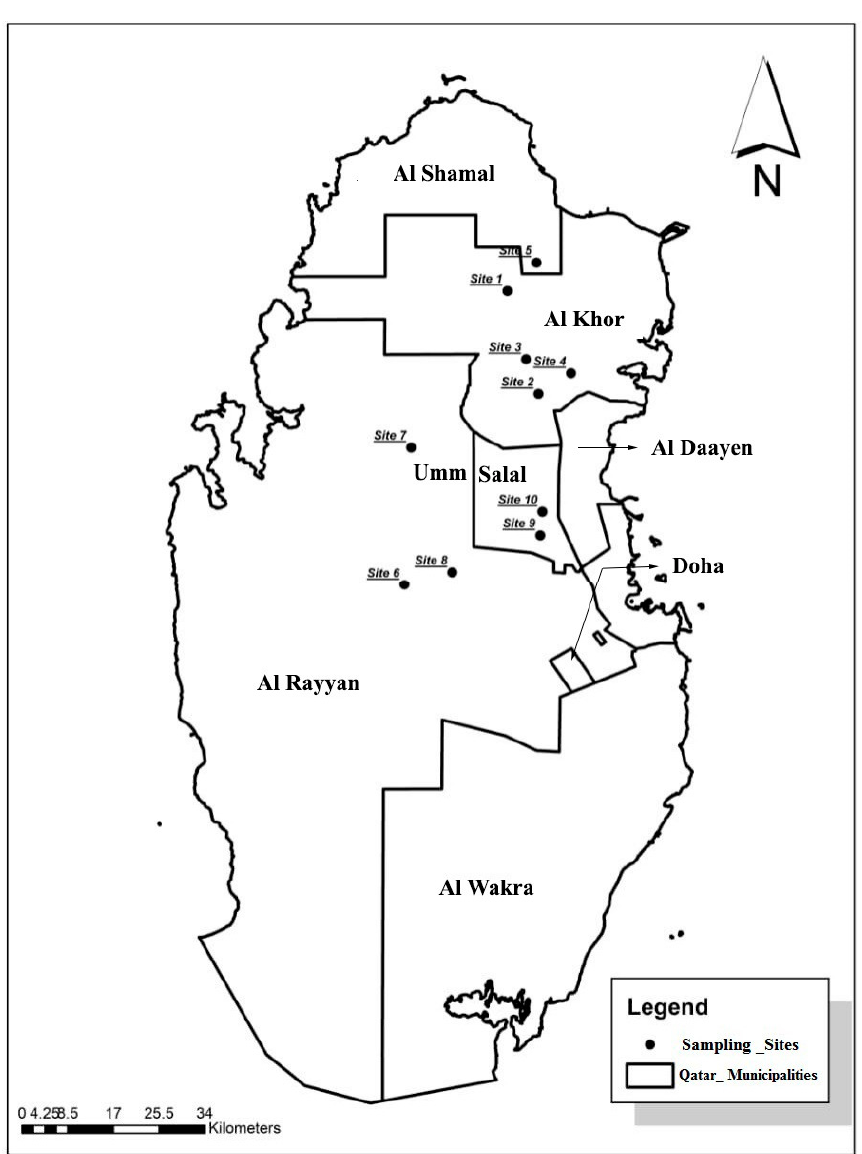
Figure 1. Sampling